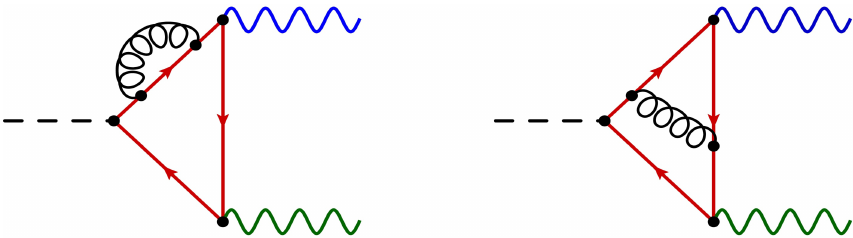
Figure 1 . Examples of Feynman diagrams contributing to the O ( αα s ) -corrections to the decay H → ZZ ∗ via a top-quark loop. The Higgs boson is denoted by a dashed line, a top quark by a red line, Z and Z ∗ by blue and green wavy lines and a gluon by a curly line.